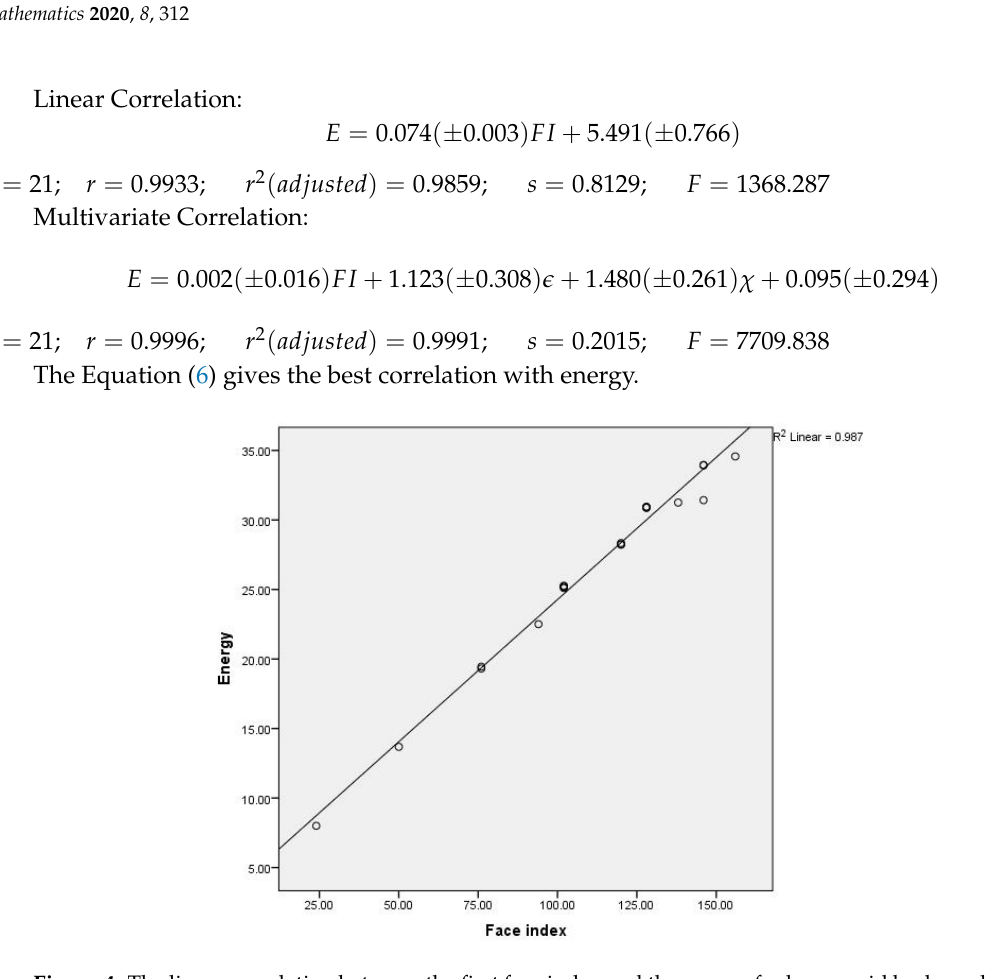
Figure 4. The linear correlation between the first face index and the energy for benzenoid hydrocarbons.